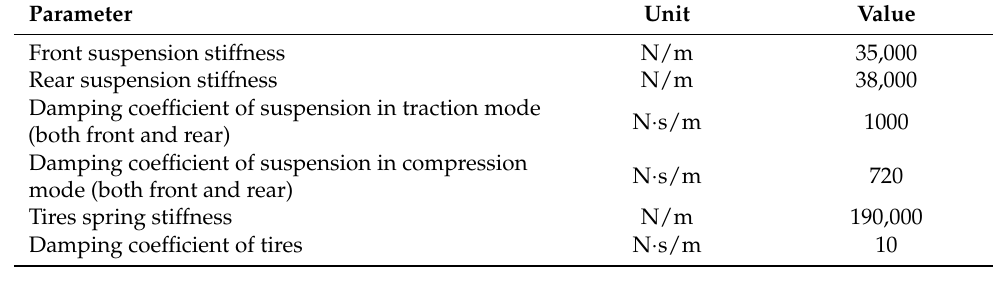
Figure 3. The details of equivalent road used in the MBD analysis. Table 4. Values of suspension system parameters.